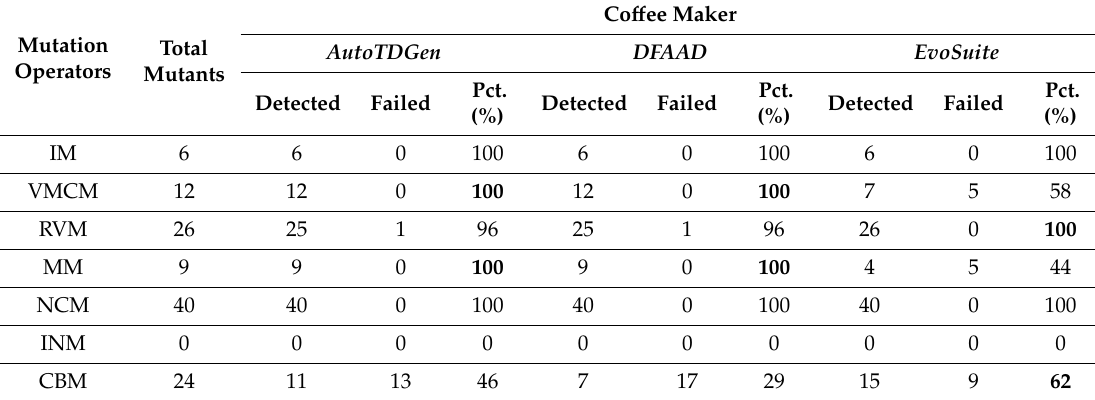
Table 7. Comparison results for the types of mutations covered in Co ff ee